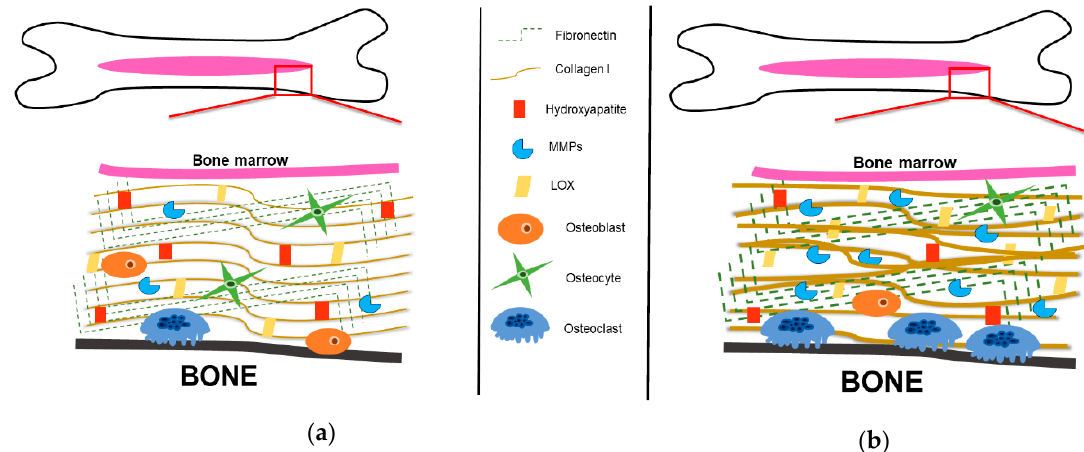
Figure 5. The bone matrix is manipulated to promote cancer growth. ( a ) The bone matrix is comprised of organic and inorganic components. The main organic component of the bone matrix is collagen type I. The bone matrix is also comprised of non-collagenous proteins, including fibronectin, lysyl oxidase (LOX), a crosslinker of collagen, and matrix metalloproteinases (MMPs), degraders of the bone matrix. Inorganic bone matrix components include hydroxyapatite crystals, which allow for mineral exchange in bone. ( b ) Under disease conditions, such as cancer, the bone matrix is constantly being remodeled. The biggest change is altered collagen production. Collagen fibrils become thick, dense, and unorganized compared to their linear, aligned counterparts. Fibronectin production increases, as well as LOX crosslinking, causing increases in tissue sti ff ness. MMP production also increases, leading to excess bone matrix degradation and remodeling.